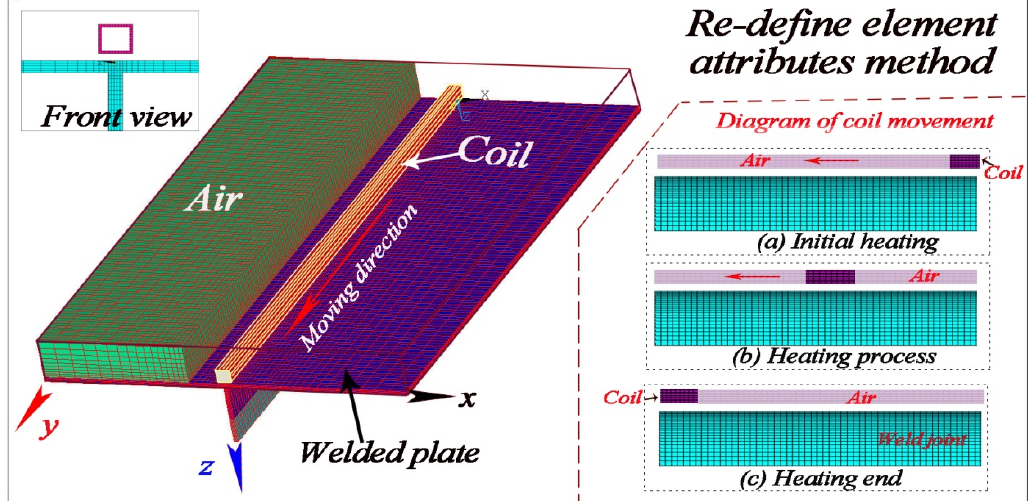
Figure 14. Principle of simulation model based on re-defined element attributes method.